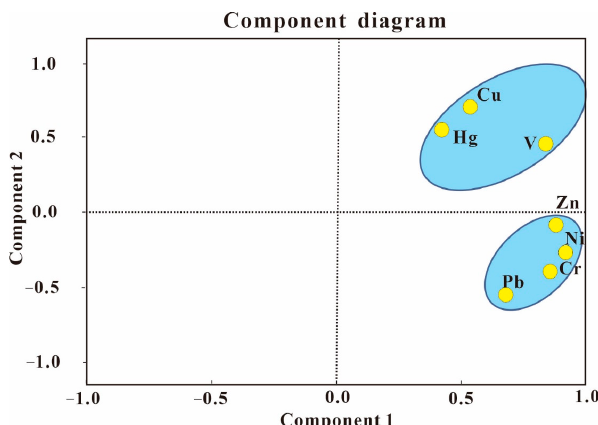
Figure 6. Two ‐ dimensional plot of scores for heavy metals obtained from the PCA results of soil. Figure 6. Two-dimensional plot of scores for heavy metals obtained from the PCA results of